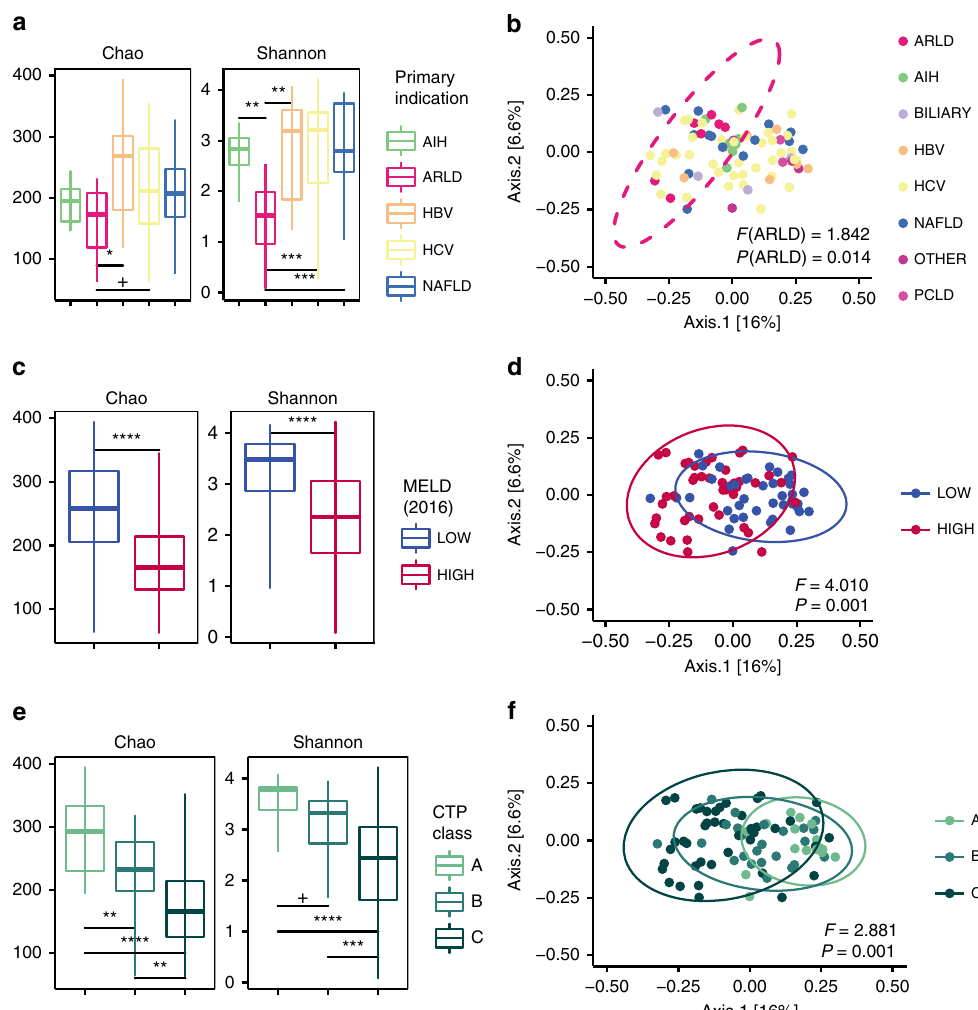
Fig. 2 Pre-transplant α -diversity and β -diversity associated with liver disease etiology and severity. a Shannon and Chao α -diversity and b UniFrac β - diversity indices strati fi ed by primary indication for LT (AIH n = 7; ARLD n = 7; HBV n = 8; HCV n = 37; NAFLD n = 14). c , d α -diversity and UniFrac β - diversity strati fi ed by high vs. low MELD score at the time of LT (> 18 ( n = 43) vs. ≤ 18 ( n = 40)). e , f α -diversity and UniFrac β -diversity strati fi ed by CTP class at the time of LT ( a ( n = 16) vs. b ( n = 24) vs. c ( n = 43)). a , c , e α -Diversity boxplots re fl ect median (horizontal center line), 25th and 75th percentile values (bottom and top bounds of boxes), and ranges (bottom and top of whiskers) for each category. Each panel shows P -values for univariate linear regression (see Table 2) as follows: + P < 0.1; * P < 0.05; ** P < 0.01; *** P < 0.001; **** P < 0.0001. b , d , f PERMANOVA P -values and pseudo-F-statistic values calculated using UniFrac β -diversity distances are shown. LT liver transplant, AIH autoimmune hepatitis, ARLD alcohol-related liver disease, BILIARY biliary-related etiologies, HBV hepatitis B virus, HCV hepatitis C virus, NAFLD nonalcoholic fatty liver disease, PCLD polycystic liver/kidney disease, MELD model for end-stage liver disease, CTP Child – Turcotte – Pugh. Source data are provided as a Source Data fi